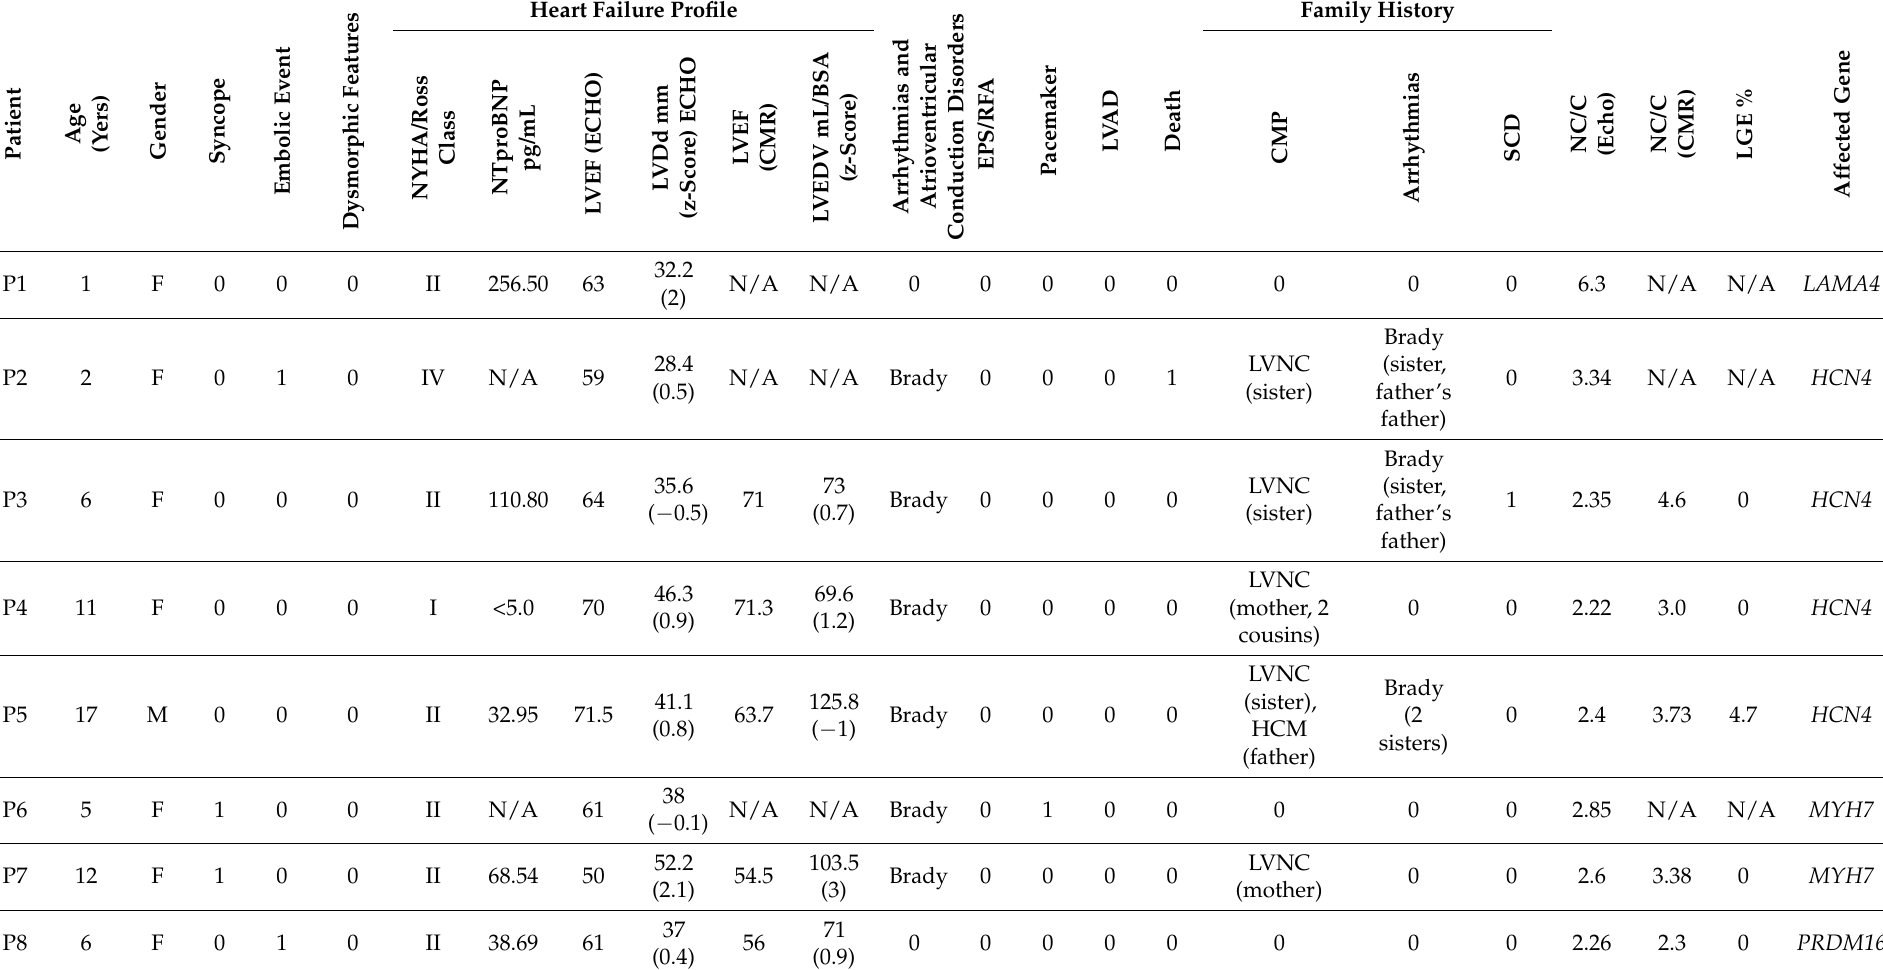
Table 1. Clinical characteristics of the